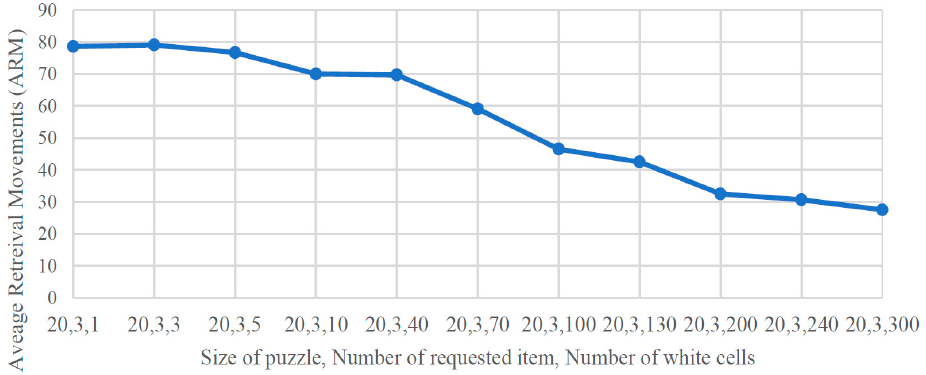
Figure 17. The effect of the number of white cells on the ARM in a 20 × 20 puzzle.